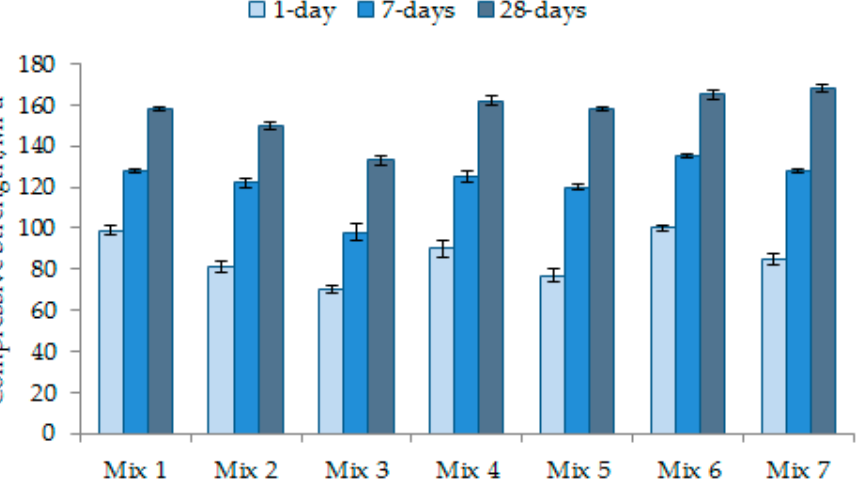
Figure 12. Compressive strength of different concrete mixes.